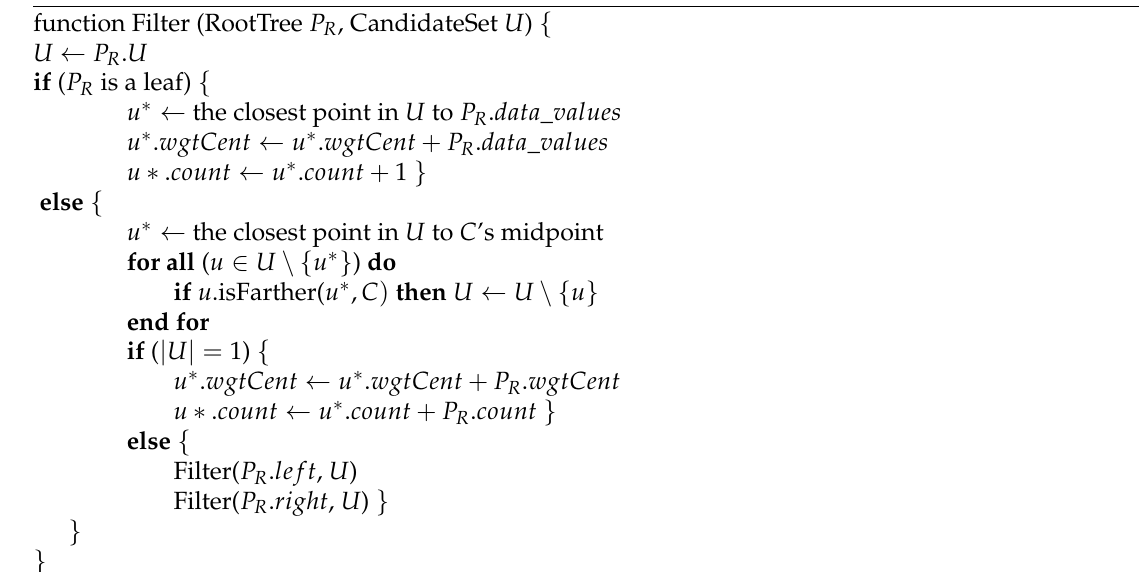
Algorithm 1 The filtering algorithm introduced in [30]. function Filter (RootTree P R , CandidateSet U )